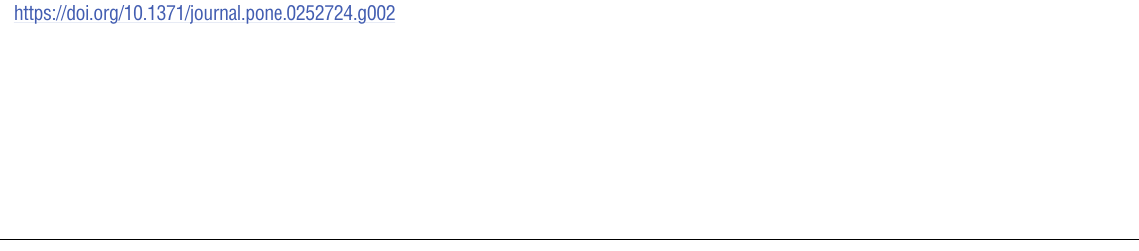
PLOS ONE | https://doi.org/10.1371/journal.pone.0252724 June 8, 2021 7 /